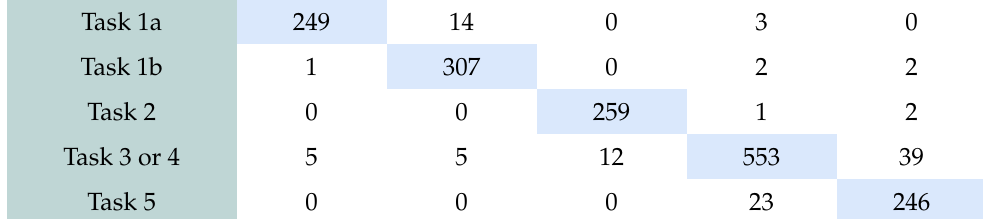
Table 4. Confusion matrix for Participant 5, based on the 5 label classification.